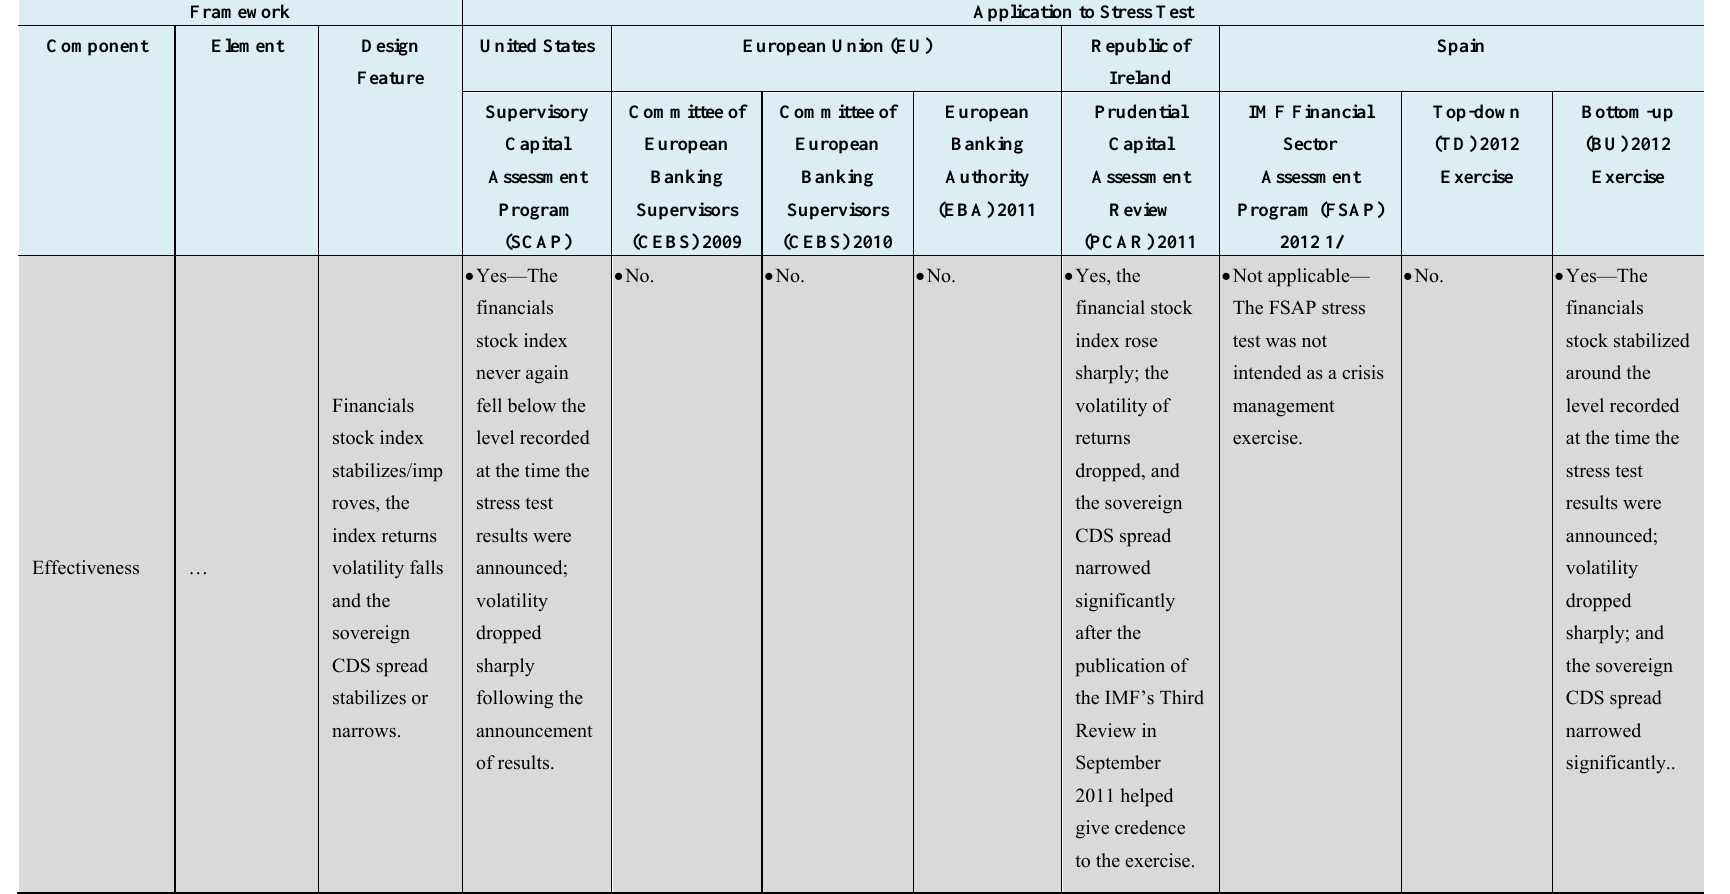
Table A1. Crisis Stress Tests: Features of